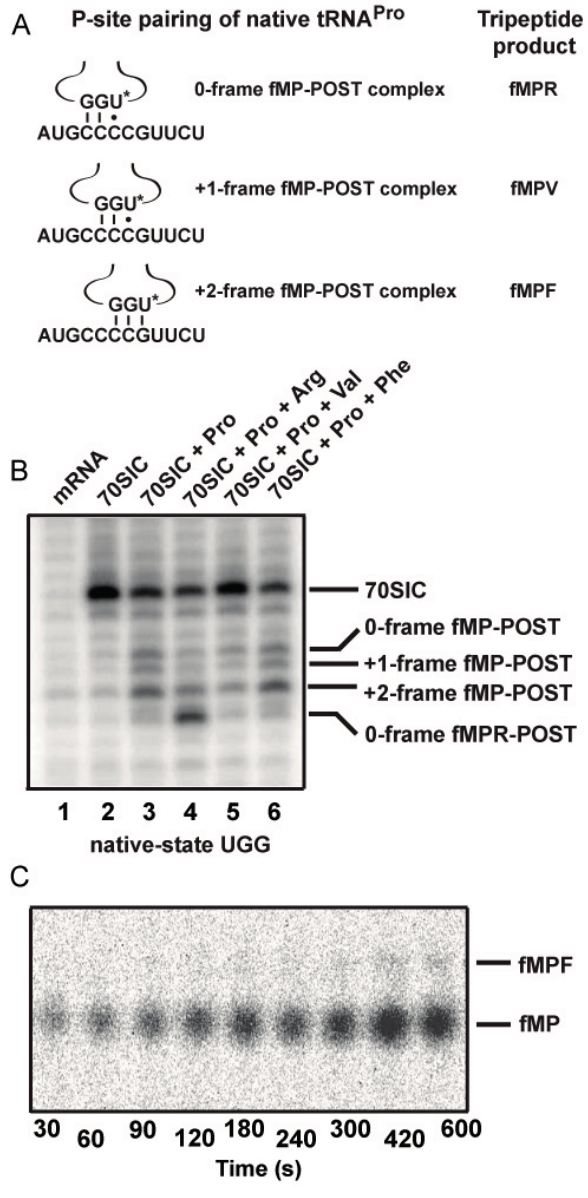
Figure 5. Dipeptidyl and tripeptidyl post-complexes formed on a slippery mRNA sequence. ( A ) Post-complexes were formed on a long mRNA that contained the initial AUG-CCC-CGU-UCU coding sequence as used in Figures 2 and 3. The fMP-post complex is shown with the native-state UGG isoacceptor in the 0-, +1-, and +2-frame. The codon-anticodon pairing interaction and the tripeptide product of each after one more round of peptide bond formation is illustrated. The U * denotes cmo 5 U34; ( B ) Toeprints of ribosome post-complexes formed by interaction of 70SIC with ternary complexes of the indicated tRNAs in the presence of EF-G. Unbound mRNA was included as a control and the 70SIC with a P-site bound fMet-tRNA fMet was used as a reference for the reading frame; and ( C ) eTLC analysis of +2-frame fMPF formation. 70SIC with an mRNA with the initial coding sequence of AUG-CCC-CGU-UCU was mixed with ternary complexes of native tRNA Pro/UGG and tRNA Phe/GAA in the presence of EF-G and incubated at 20 °C. Aliquots were quenched in 0.5 M KOH prior to analysis by